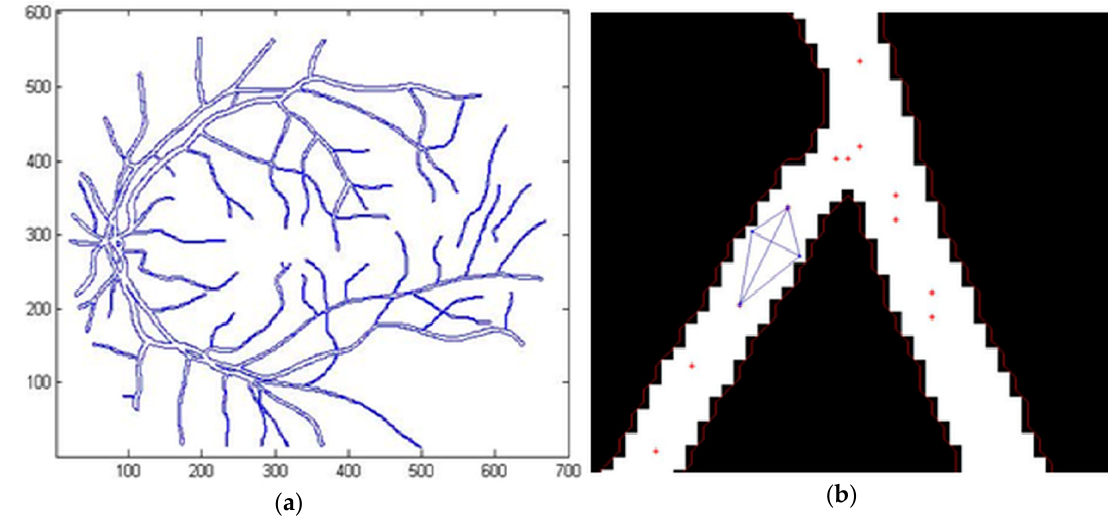
Figure 11. Calculation of the blood vessel diameter: ( a ) Contour detection; ( b ) Image depicting the calculation of the blood vessel diameter (the blue lines represents the triangles detection and the red dots represents the characteristic points).